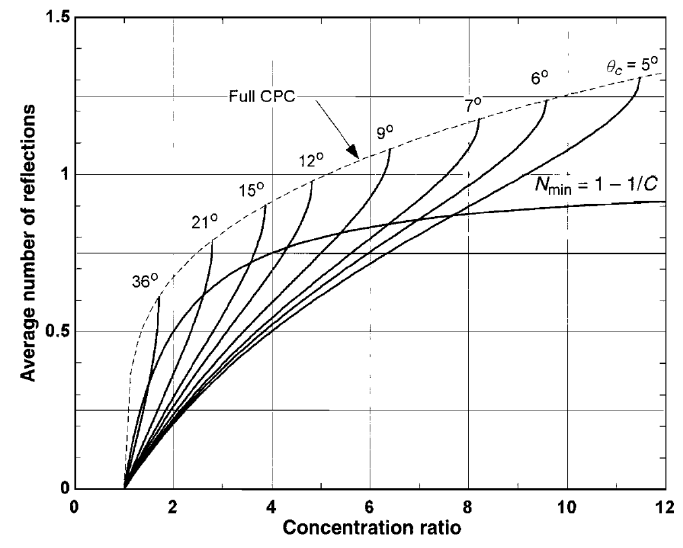
Figure 5. Relationship between concentrating ratio, average number of reflections, and truncation ratio